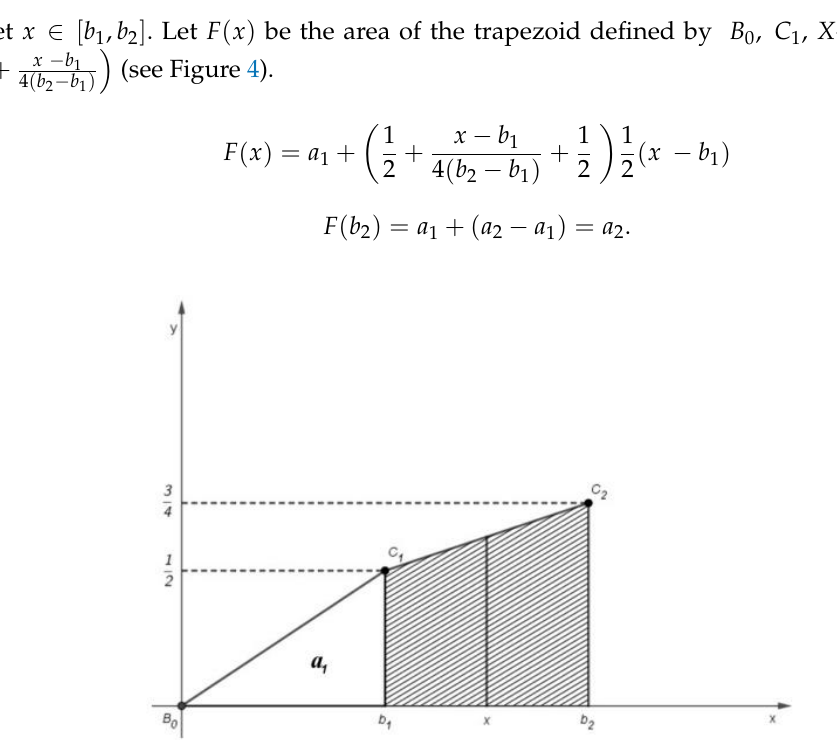
Figure 3. The area of the trapezoid defined by points 𝐵 1 ,𝐶 1 , 𝐵 2 , 𝐶 2 .